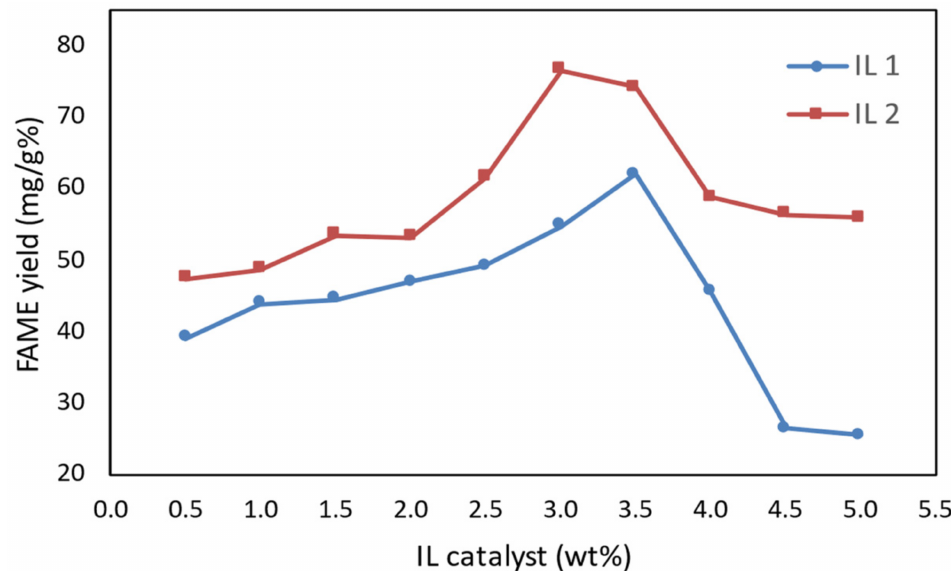
Figure 2. Effect of ILs catalyst on FAME yield.